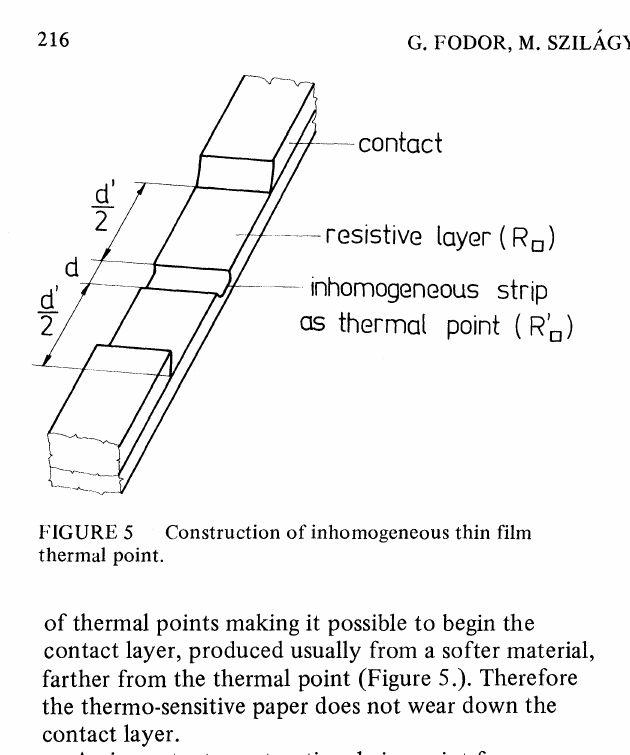
Construction of inhomogeneous thin film thermal point. of thermal points making it possible to begin the contact layer, produced usually from a softer material, farther from the thermal point (Figure 5.). Therefore the thermo-sensitive paper does not wear down the contact